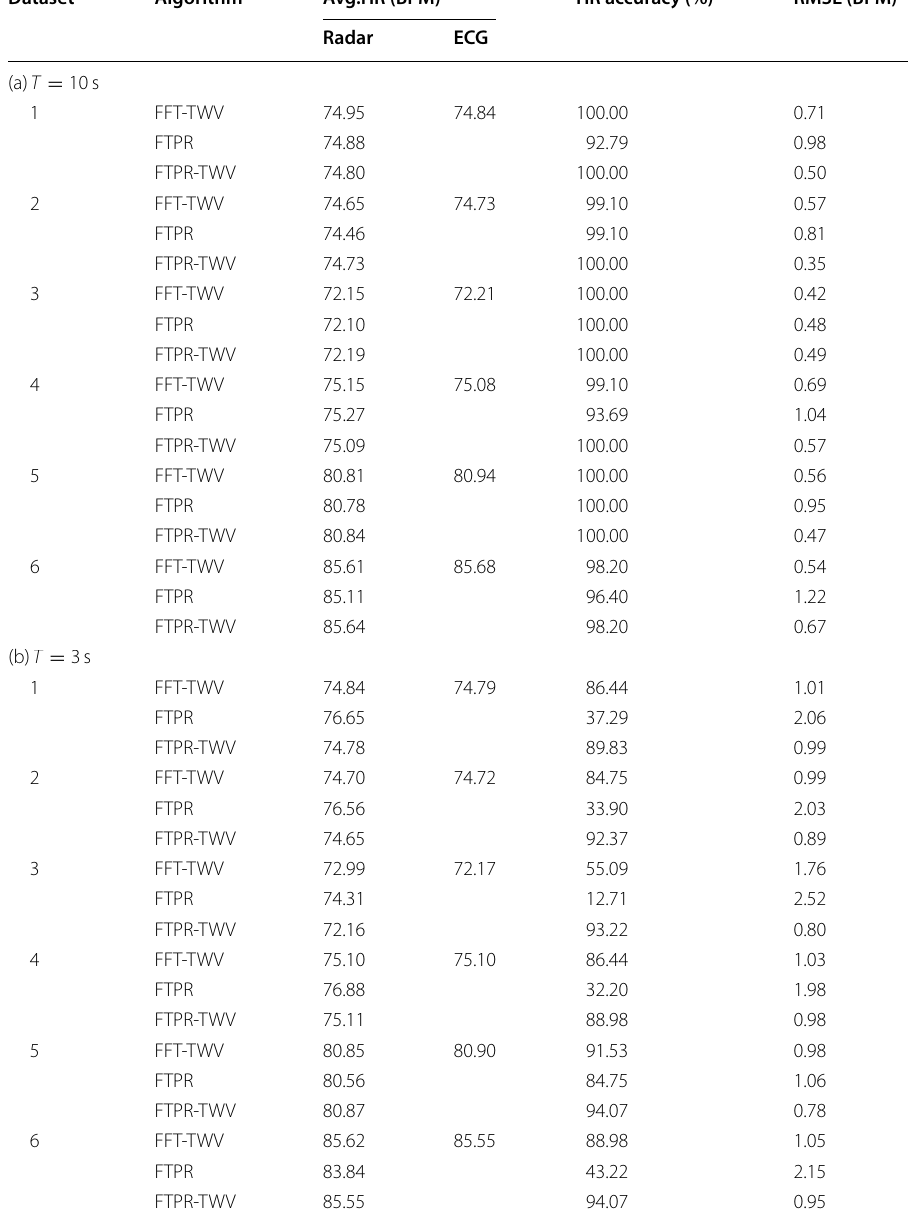
Table 2 HR estimation results